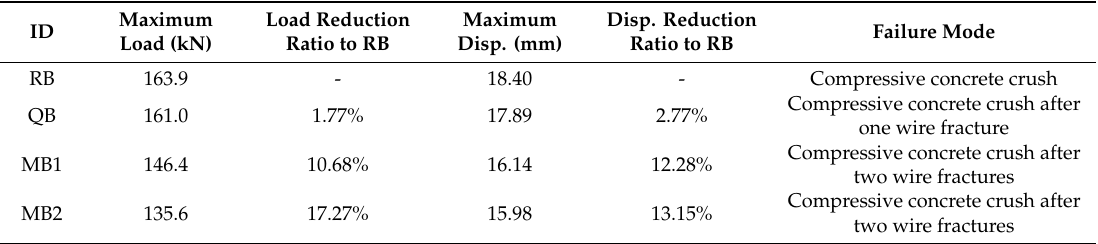
Figure 16. Load–displacement curves of PSC beam specimens. Table 3. Test results of PSC beam specimens.